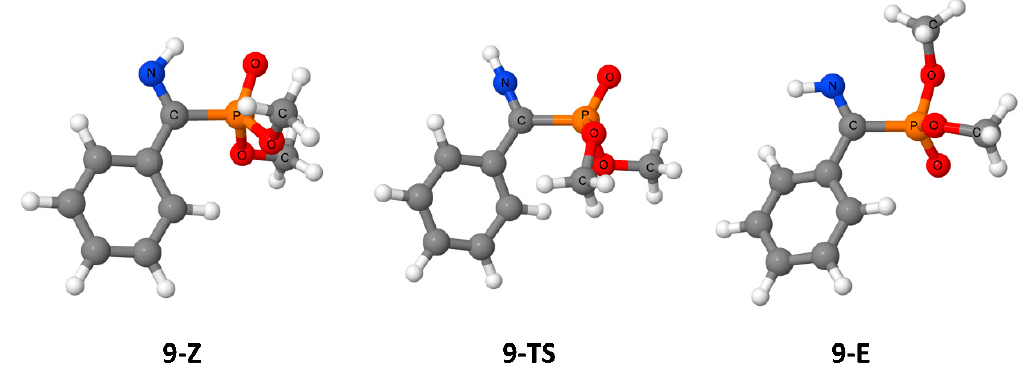
Figure 12. Optimized structures of the Z- and E-isomers of compound 9 ( 9-Z and 9-E , respectively), and the structure corresponding to the transition state of the isomerization reaction ( 9-TS ).